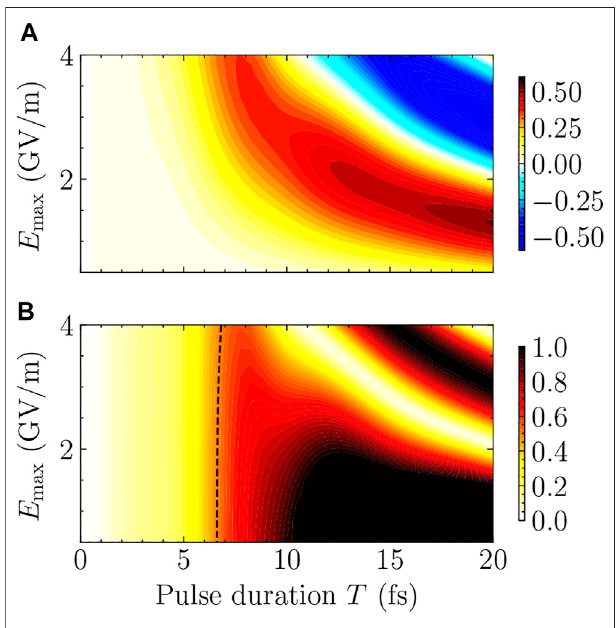
FIGURE 3 | (A) Color-coded contour plots for the deviation P FNA e ( t f ) − P e ( t f ) between P FNA e ( t f ) in Panel 2A and P e ( t f ) in Panel 2B for T ≤ 20 fs. (B) Color-coded contour plots for the relative error δ P e of P FNA e ( t f ) with respect to P e (cid:2) 50 % P e ( t f ). The black dashed curve indicates δ P e P e